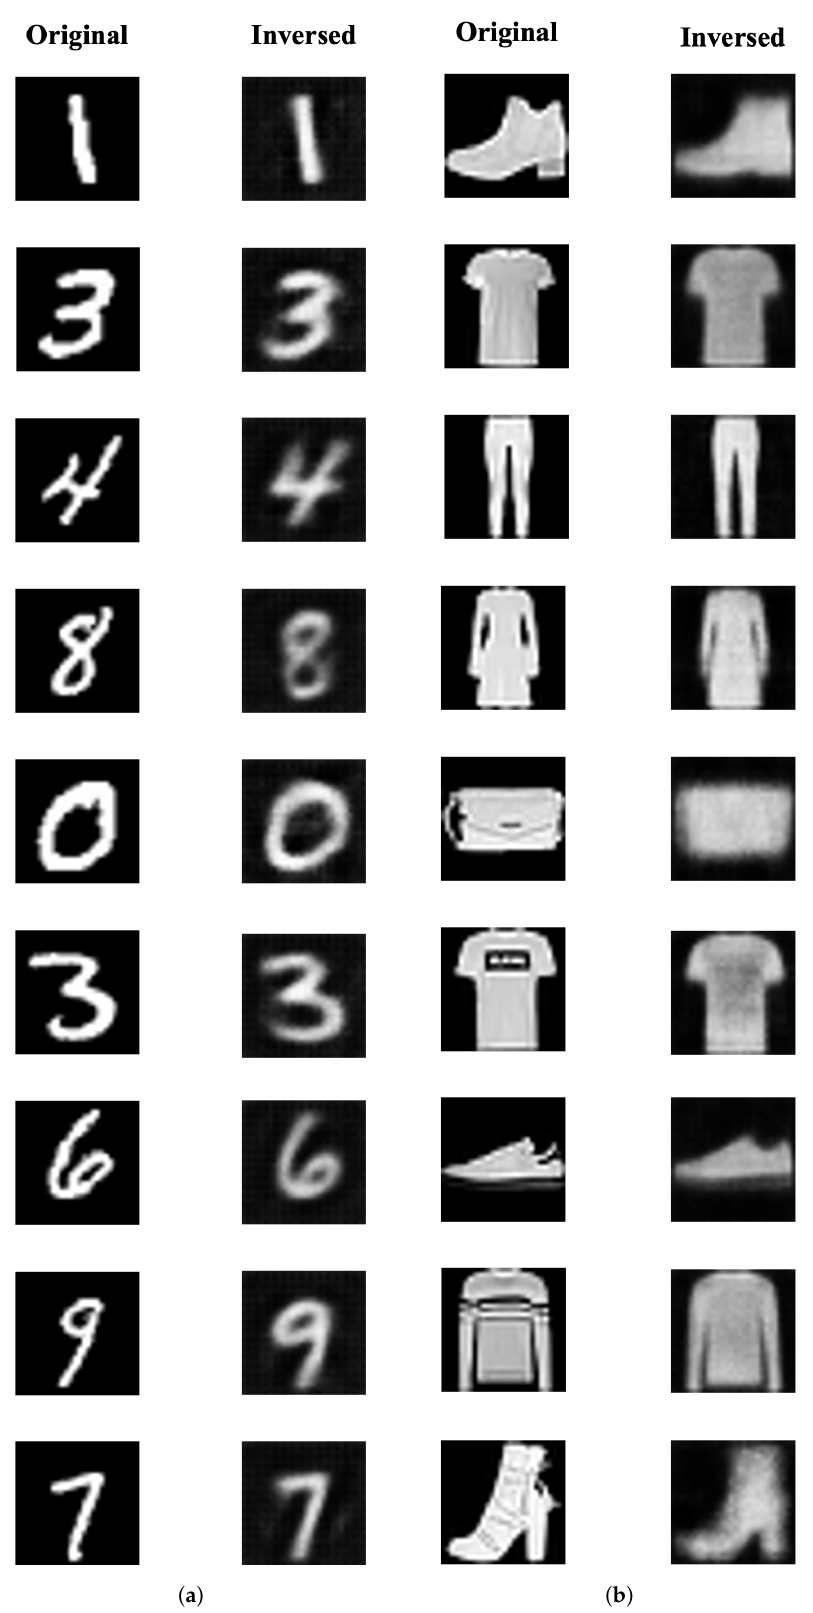
Figure 4. Reconstruction results on MNIST and Fashion-MNIST datasets. ( a ) MNIST dataset. ( b ) Fashion-MNIST